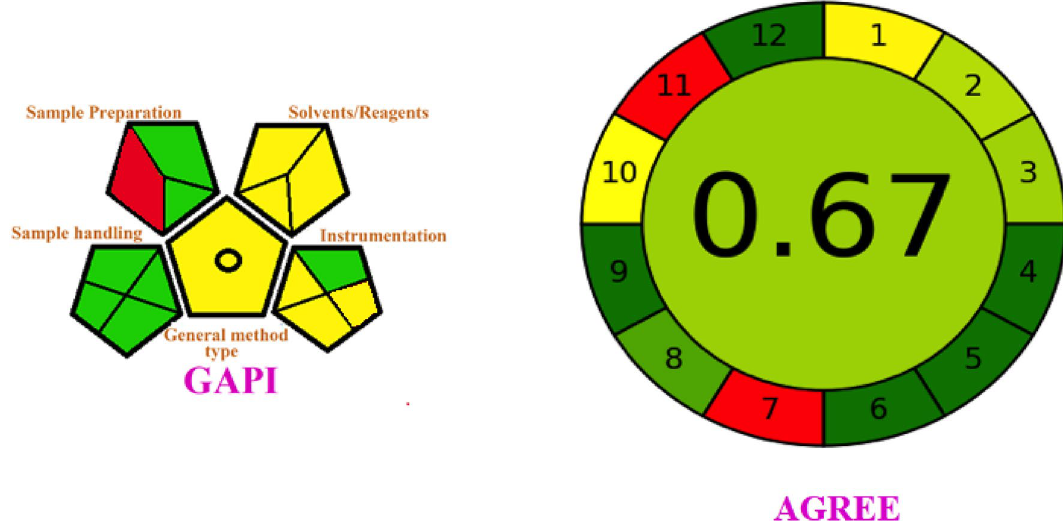
Figure 8. Method greenness assessment tools